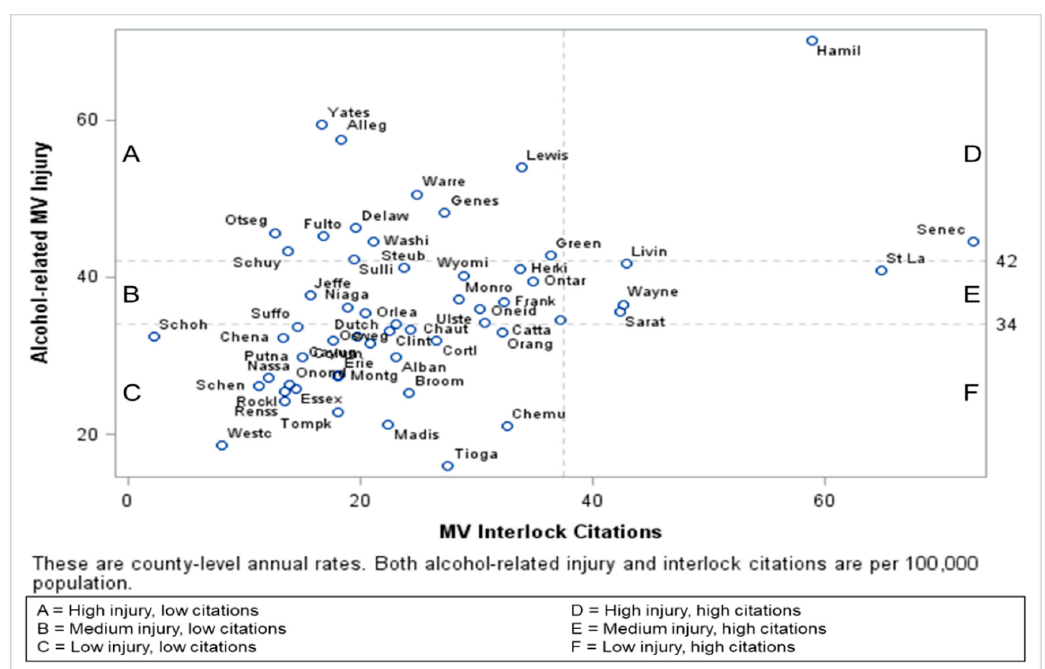
Figure 3. County-level annual rates of alcohol-related MV injury by interlock citations in NYS per 100,000 population.